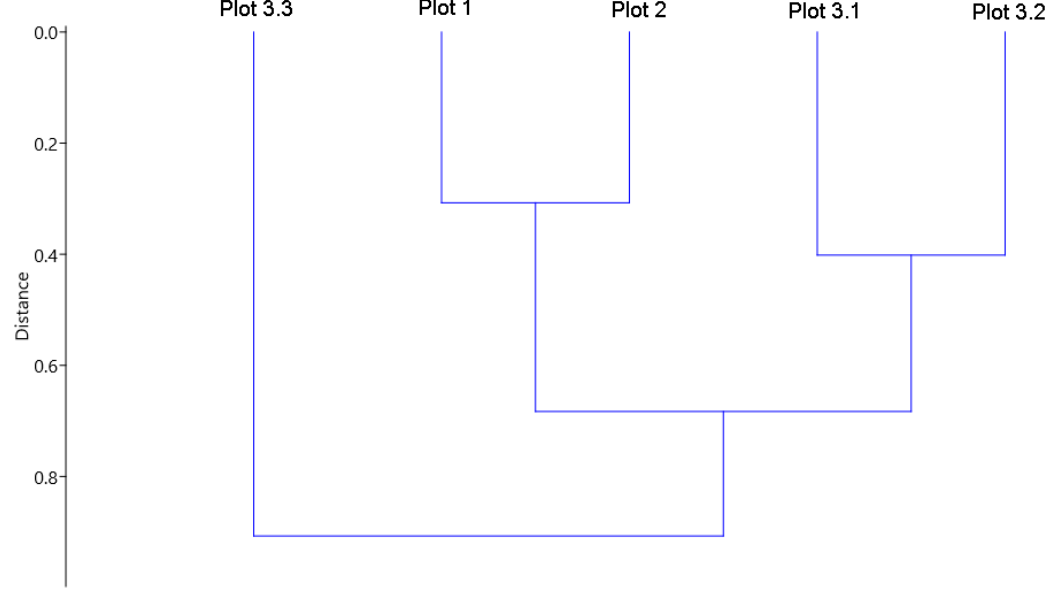
Figure 1. Dendrogram of helminth composition similarity according to Jaccard similarity index ( C J ). Cophenetic Correlation Coefficient: r = 0.780.